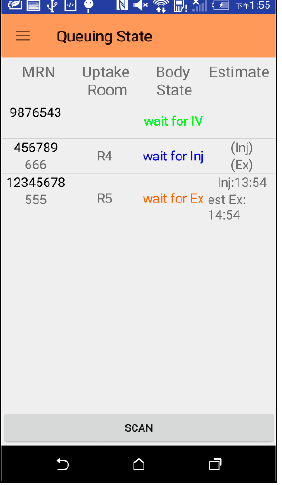
Figure 14. Waiting list for scan rooms and patient queues for each scan room.